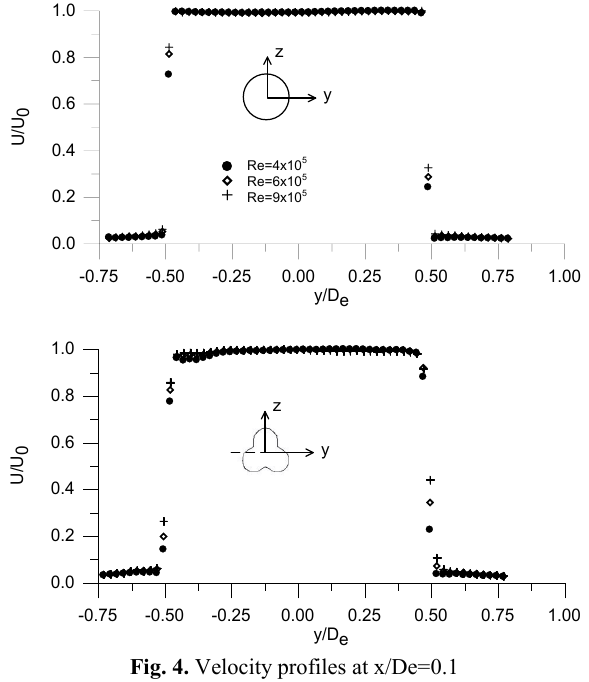
Fig. 4. Velocity profiles at x/De=0.1